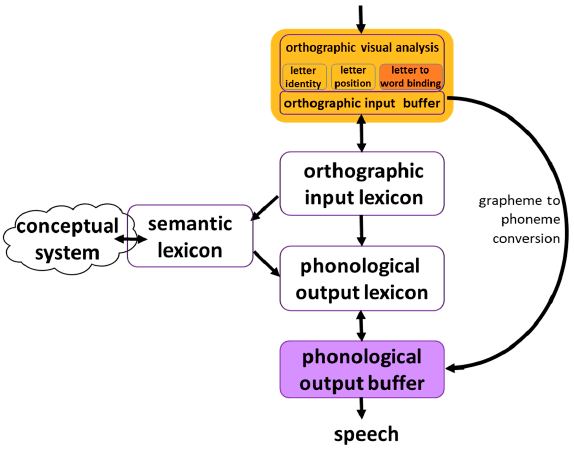
Figure 1. The dual route model of reading.